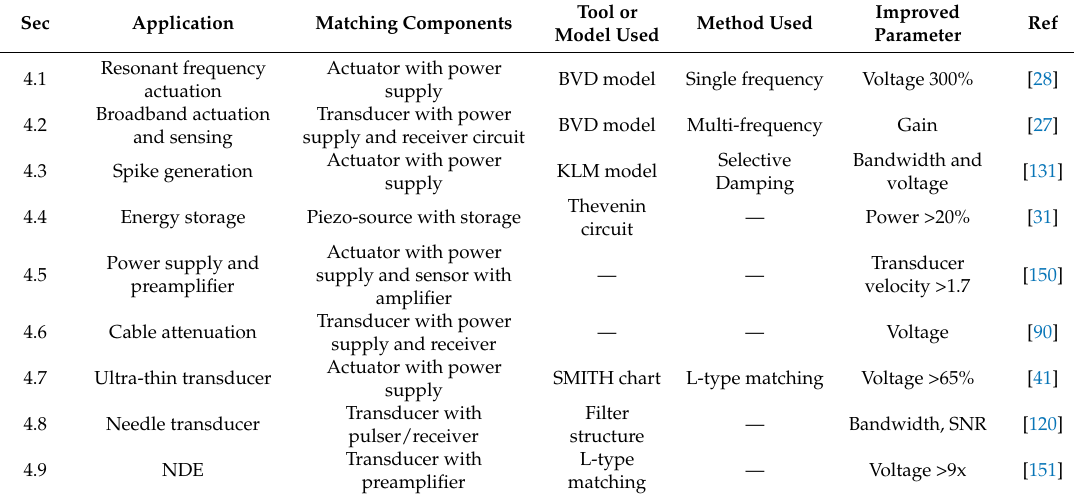
Table 2. Applications using electric impedance matching networks with appropriate tools, models, and methods used with appropriate reference for new